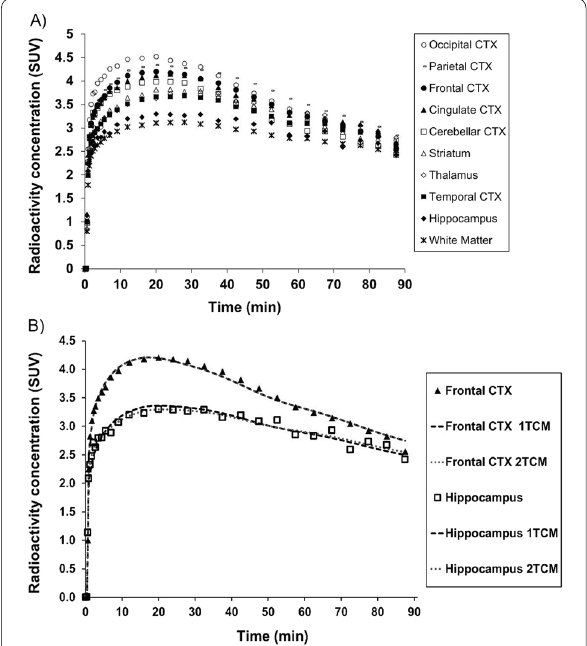
Fig. 2 Time-activity curves (TACs) from 90-min 11 C-CPPC PET data of a representative subject. ( A ) TACs across ten regions of interest (ROIs) are shown as SUV (injected dose per cm 3 tissue normalized to body weight in grams). ( B ) Visually, the one-tissue compartment model (1TCM) and two-tissue compartment model (2TCM) fit the observed tissue TACs in all ROIs. Observed activity (data in shapes) and model curves (bold dash curve, 1TCM; smaller dash curve, 2TCM) from frontal cortex and striatum are shown. Cortex,